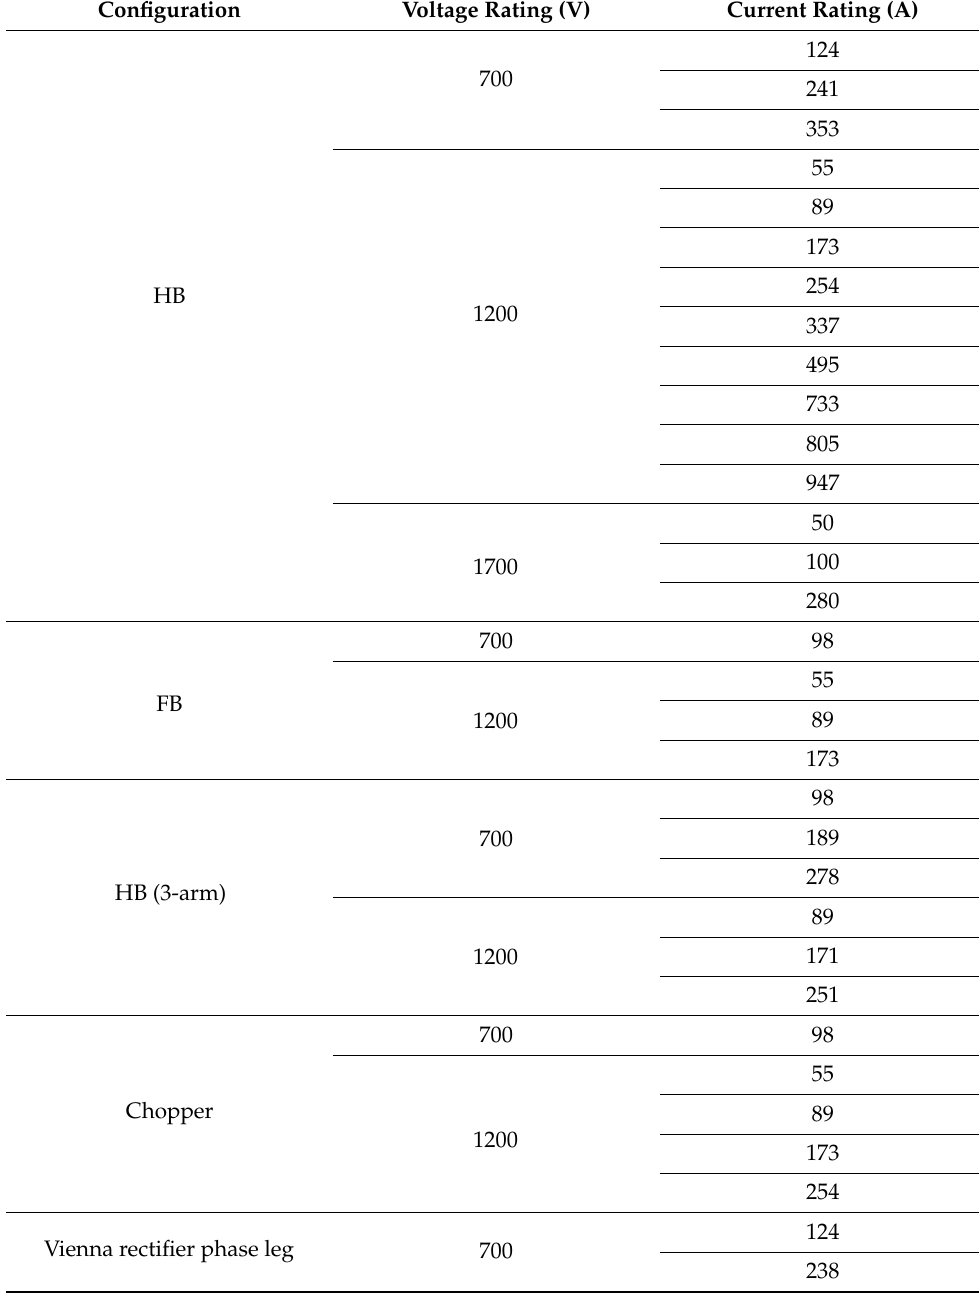
Table 17. Commercial SiC MOSFET modules by Microchip.